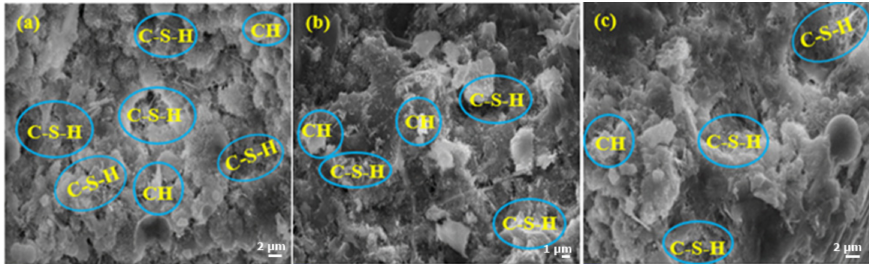
Figure 14. 7-days SEM images of ( a ) Control, ( b ) FBP5, and ( c ) FBP10 samples.